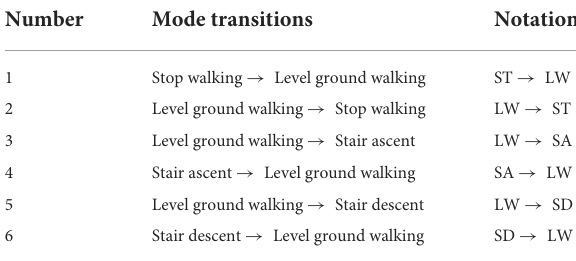
TABLE 1 Notations used for different terrain